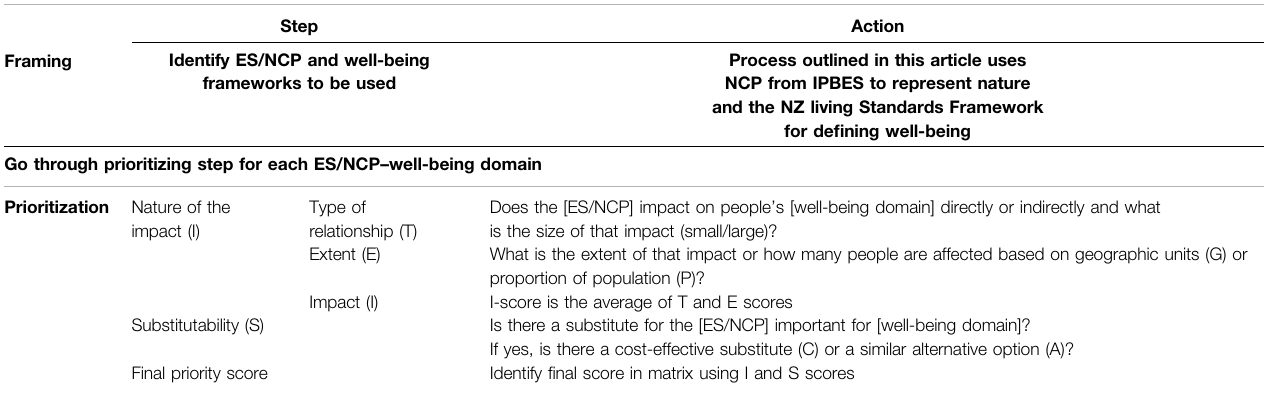
( Table 1 ). A series of questions ( Table 2 ) was used to aid the scoring process and guide discussions. The scoring system was ordinal with corresponding scores from no/weak (1) to strong (5) interaction for each criterion and was applied to each ES/ NCP – well-being domain. While the ordinal categories covered the full range of possible interactions the description of the categories was arbitrary. While the authors experience in